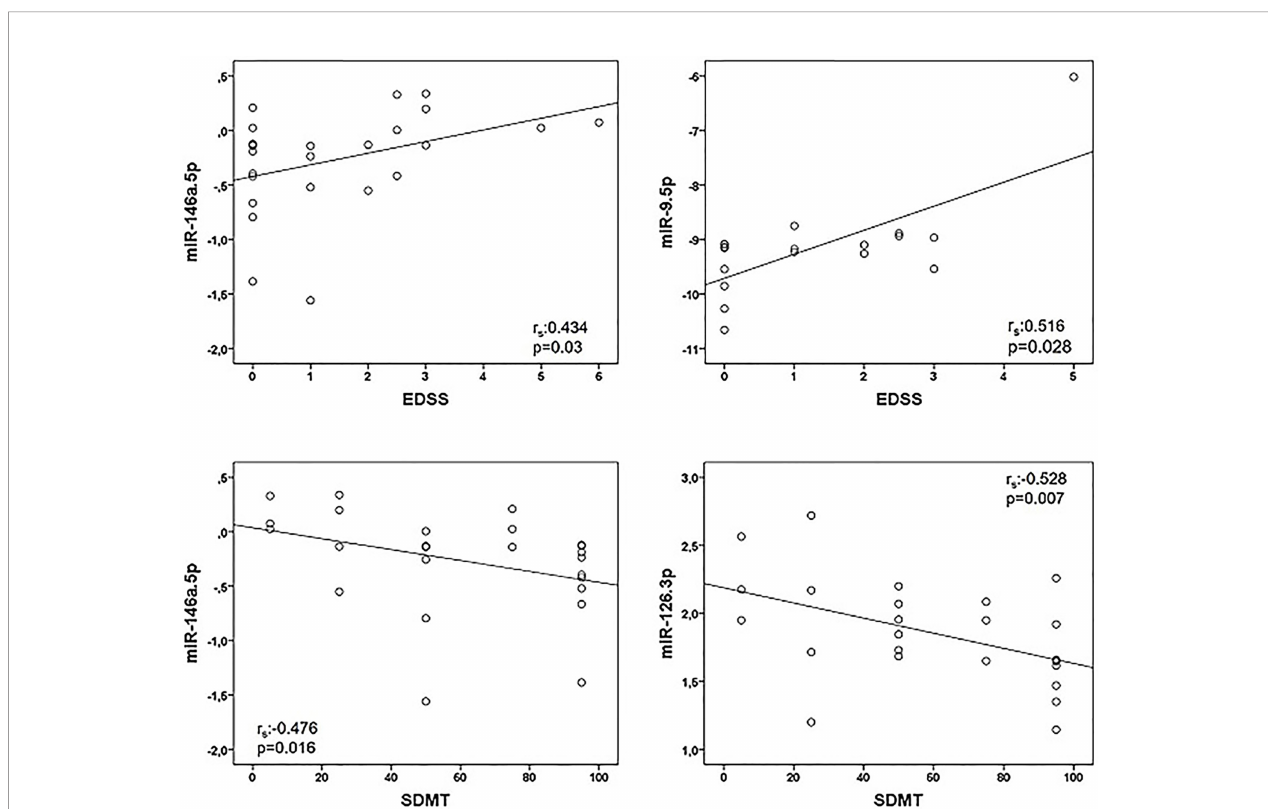
FIGURE 1 | Correlations between microRNAs (miRNAs) expression levels and clinical variables in multiple sclerosis patients. Twenty- fi ve multiple sclerosis patients were assessed in all correlations except that of miR-9-5p and EDSS (n = 18). Spearman correlation test was used for statistical analysis. EDSS, Expanded Disability Status Scale; r s , Spearman correlation coef fi cient; SDMT; Symbol Digit Modalities